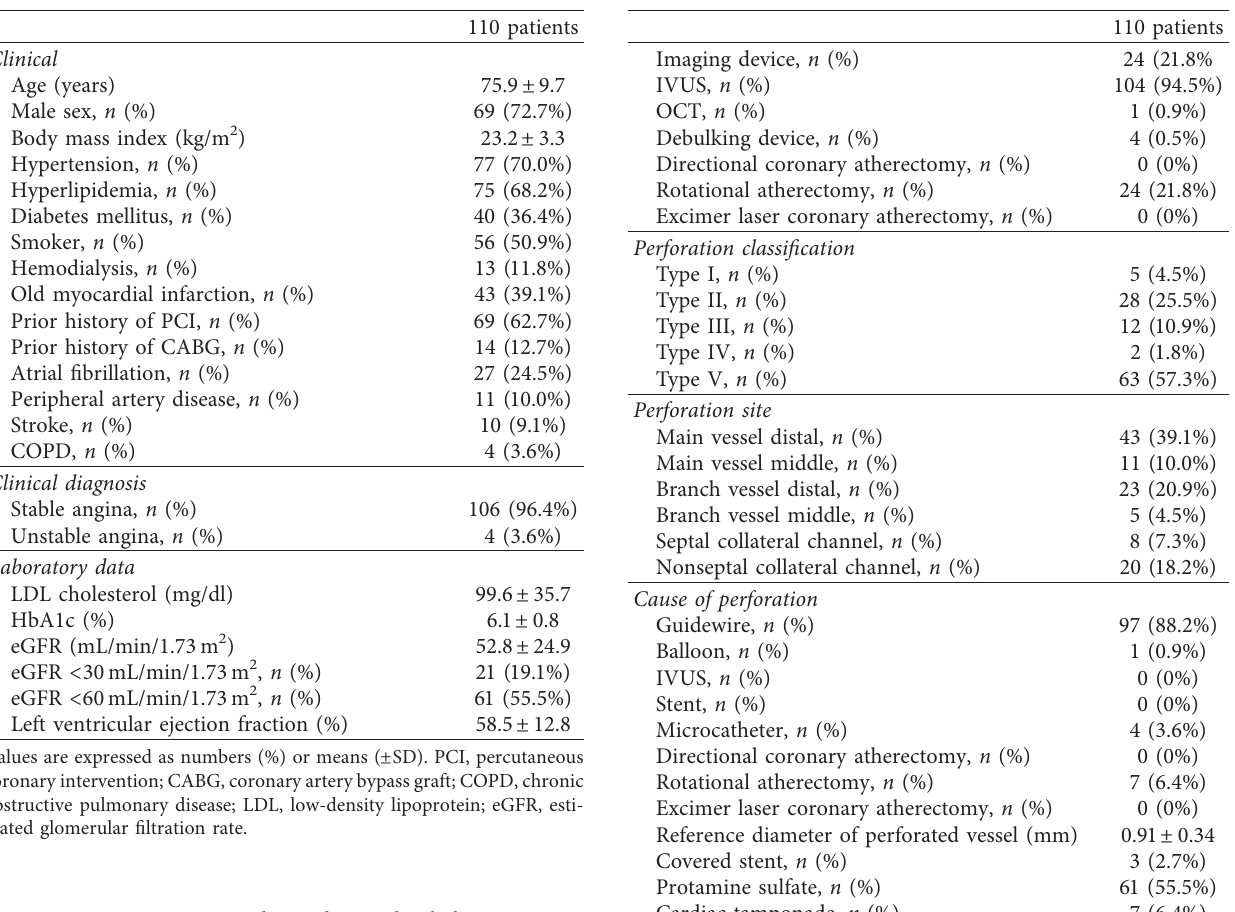
Table 1: Baseline clinical characteristics and medication.